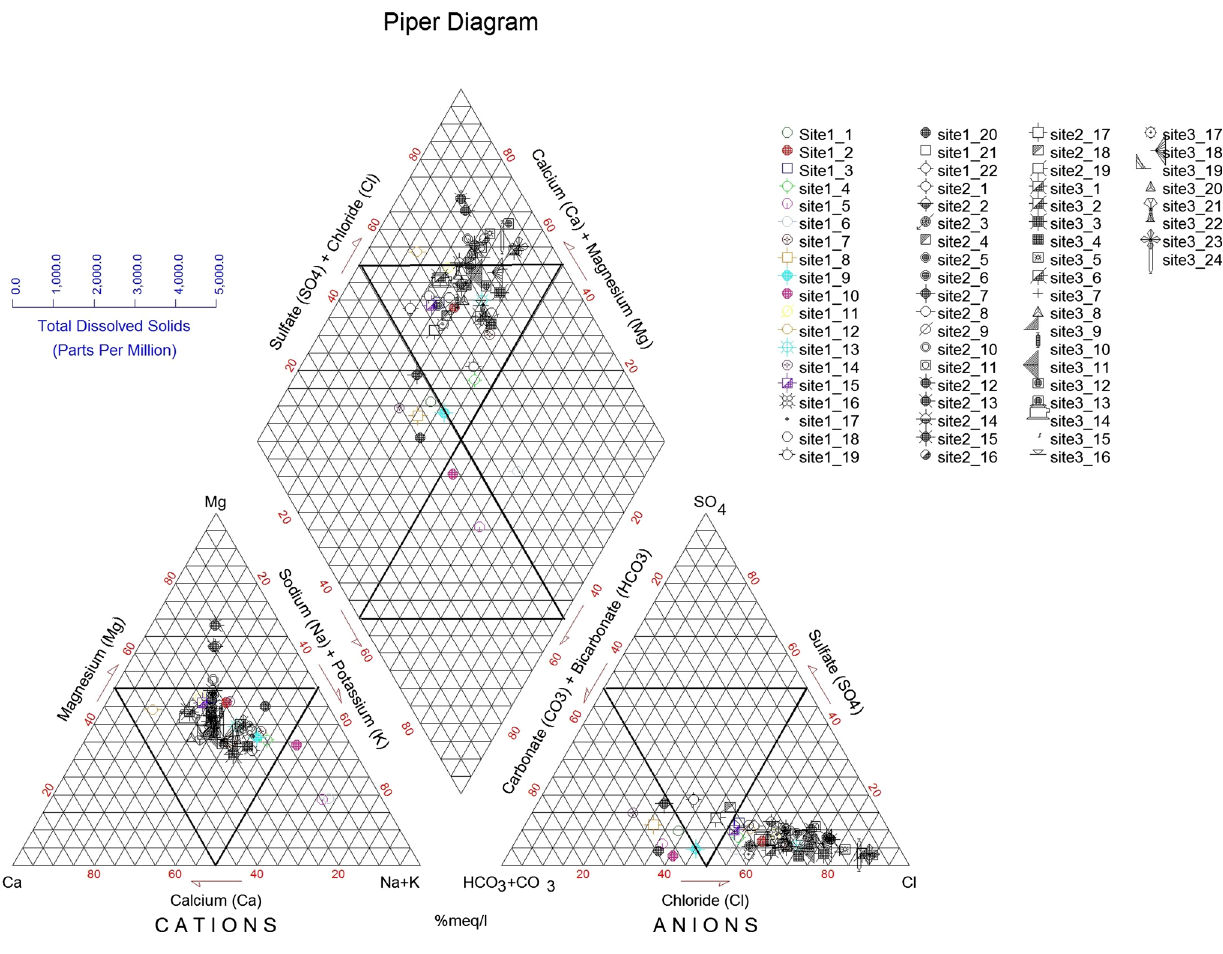
Fig. 3 Piper trilinear diagram for sites 1, 2 and 3 hydrochemical facies for sites 1, 2 and 3